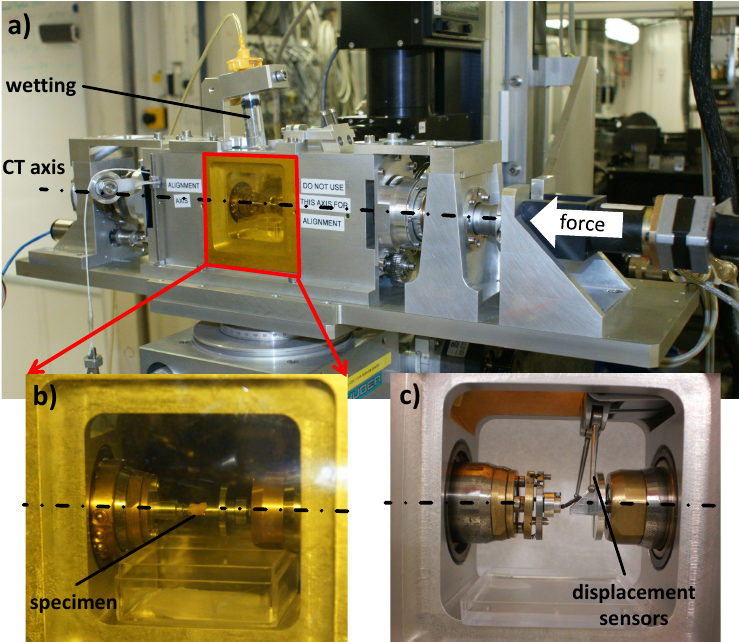
Figure 2. The TomoPress in operation at beamline ID19 of the ESRF: ( a ) the complete system (cf. sketch in Figure 1)—the central frame with the sample has been sealed with Kapton windows (yellow) to maintain locally a constant humidity, above a syringe is visible to wet the sample between scans; ( b ) closeup showing the TomoPress equipped with standard clamps and a mounted sample (rat bone, cf.